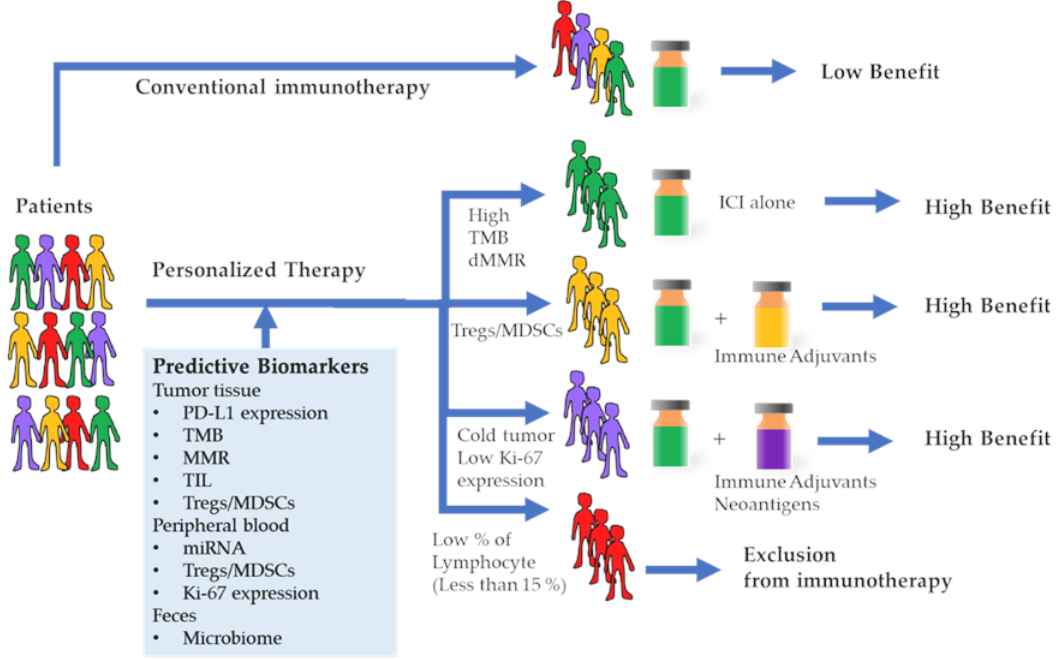
Figure 1. Cancer immunotherapy treatment outcomes based on predictive biomarkers. Conventional immunotherapies were performed without a predictive biomarker, hence the benefit was low. Patients with a high tumor mutation burden (TMB) or deficient mismatch repair gene (MMR) will respond well to the immune check point inhibitor (ICI) alone. Patients with a high amount of regulatory T cells (Treg) and / or myeloid-derived suppressor cells (MDSC) will require combination immunotherapy of ICI and agents that resolve suppressive immunity. Patients with cold tumors and / or low Ki-67 expression in peripheral blood mononuclear cells (PBMC) will require a combination therapy of ICI and immune adjuvants as well as vaccination against the neoantigens. Patients with a low percentage of peripheral lymphocytes might be regarded as unsuitable candidates for